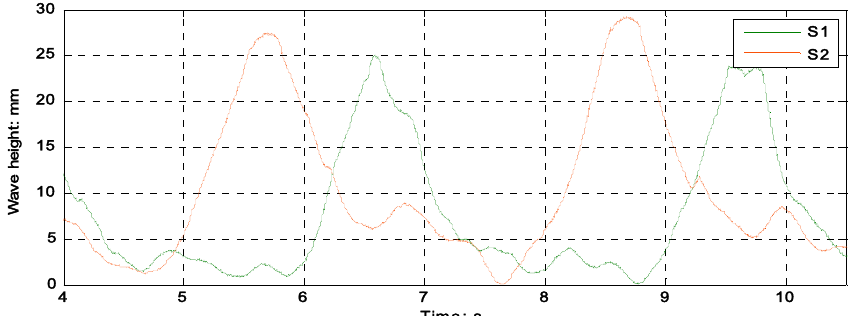
Figure 13. Waveform curves when the wave height is 0.3 m and the wave period is 3 s. (S1 is the wave curve after the ACWEC; S2 is the wave curve before the ACWEC).